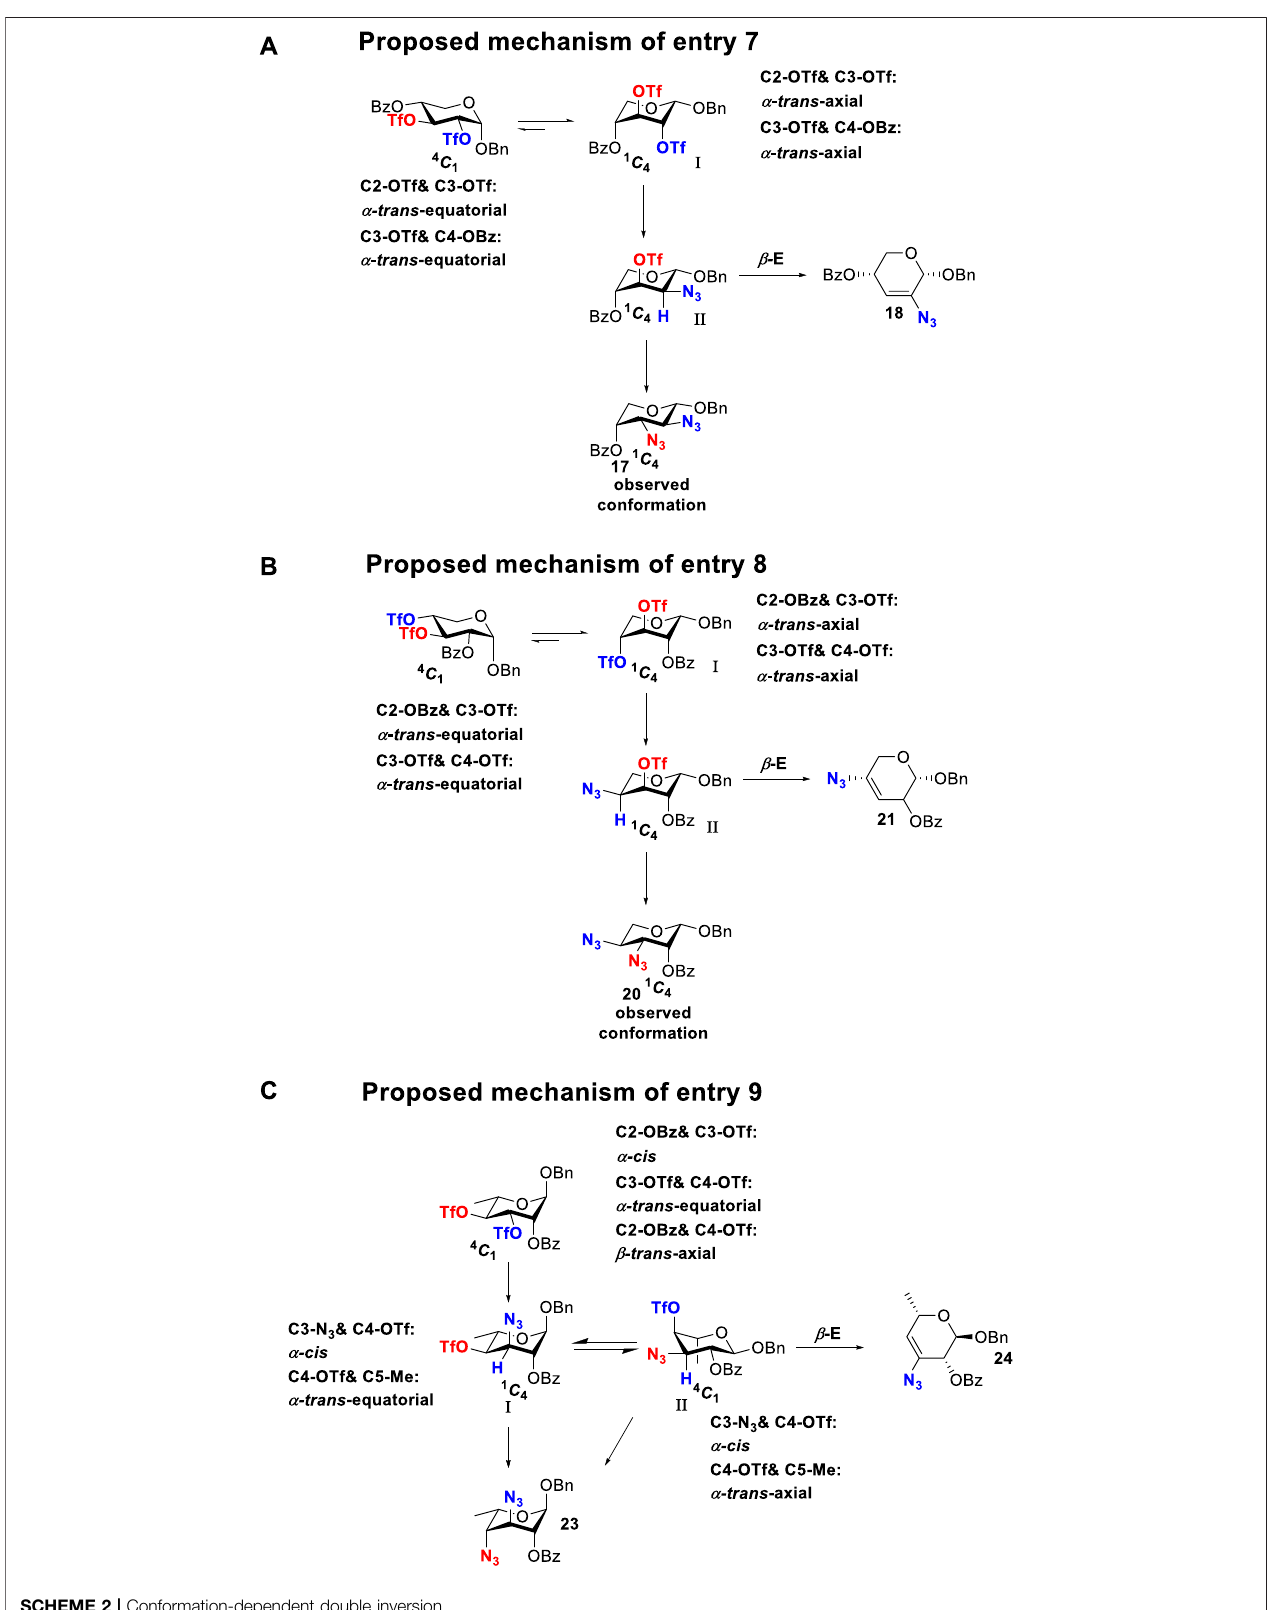
Frontiers in Chemistry |